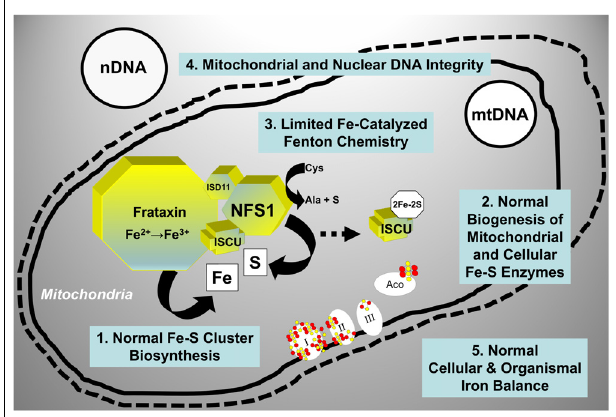
FIGURE 3 | Molecular components involved in the initial step of mitochondrial ISC synthesis and their biological roles. When mitochondrial ISC synthesis functions normally, vital enzyme activities are maintained throughout the cell, iron-catalyzed oxidative damage is limited, and there is a balance between iron uptake and iron utilization. See text for additional details. NFS1, cysteine desulfurase; ISD11, adaptor protein required for NFS1 stability; ISCU, scaffold protein; I, II, III, respiratory chain complexes I, II, and III; Aco, mitochondrial aconitase; mtDNA, mitochondrial DNA; nDNA, nuclear